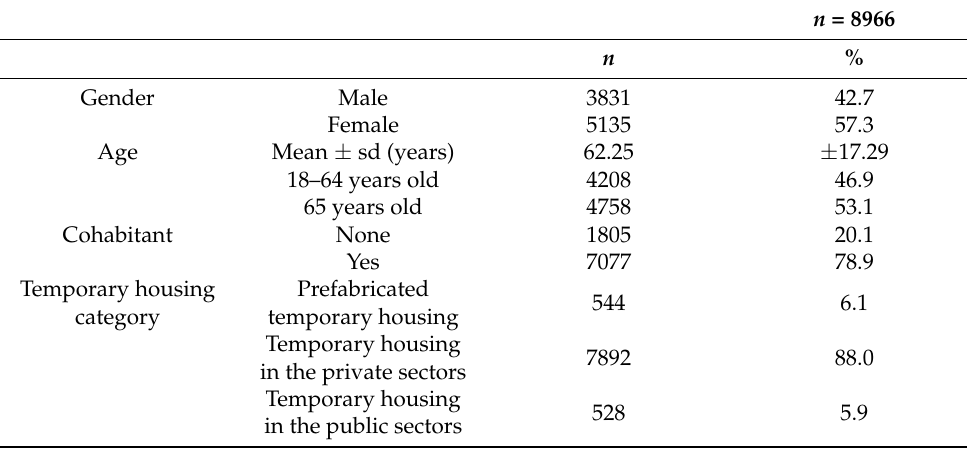
Table 1. Demographics of the